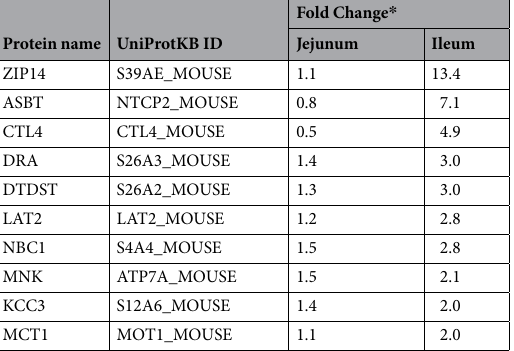
Table 3. Fold change of intestinal expression levels of EGCg transporter candidates. * Fold Change of the average expression levels in the catechin group to the control group (n =